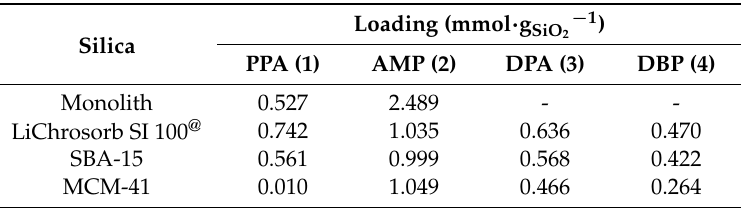
Functionalization of the silicas with different phosphonic and phosphoric